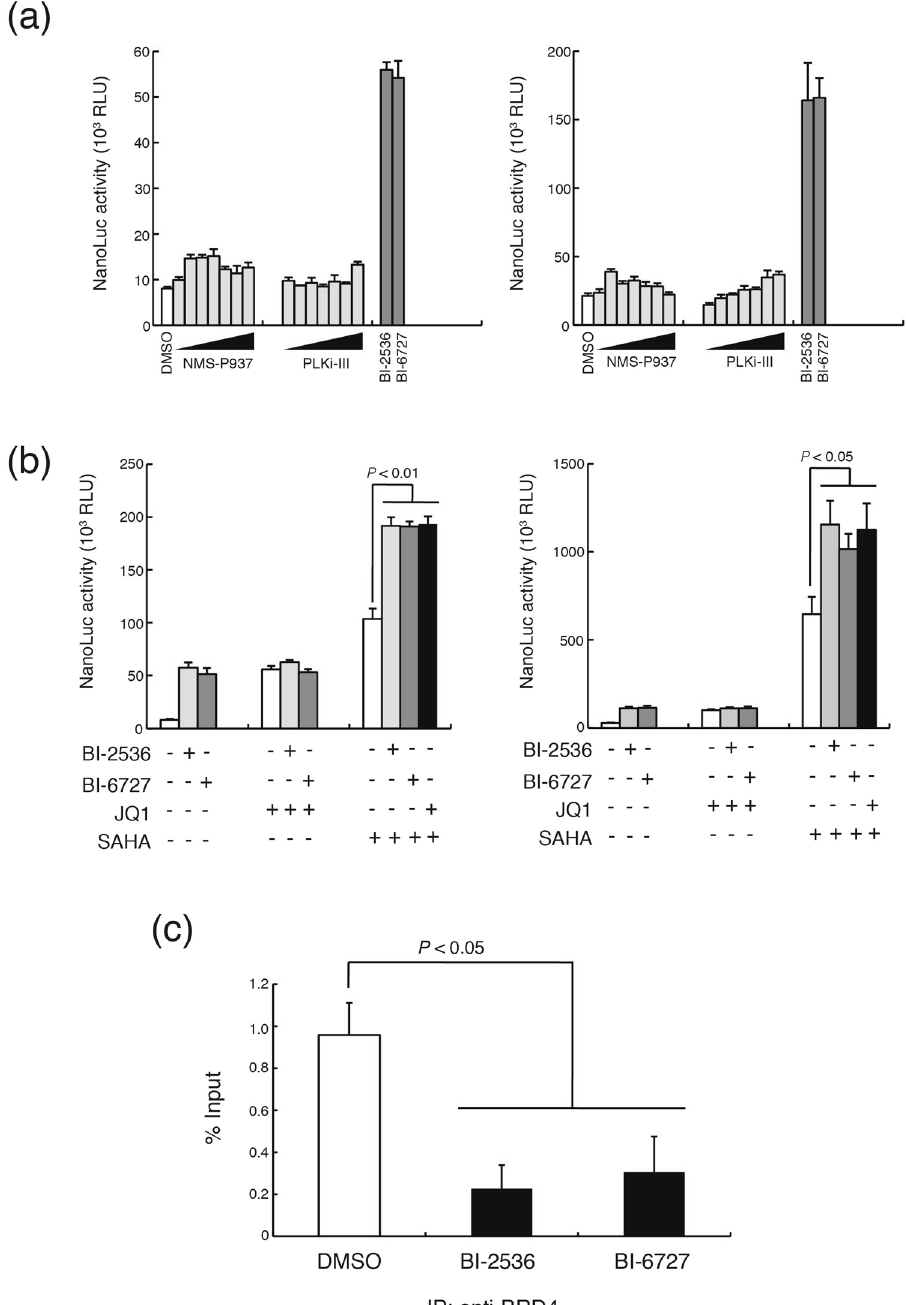
Figure 5. BI-2536 and BI-6727 activate HIV-1 LTR transcription probably through bromodomain inhibition rather than PLK inhibition. ( a ) #95 and #225 THP-1-NanoLuc clones were cultured in 0.1% dimethyl sulfoxide (DMSO) in the absence or presence of NMS-P937 or PLKi-III at 0.01, 0.03, 0.1, 0.3, 1, 3, and 10 μ M for 24 hours. The clones were also cultured with 1 μ M BI-2536 or 1 μ M BI-6727. After the clone cells were harvested and lysed, the NanoLuc activity of cell lysates was determined. Each value is shown as a mean ± standard deviation (SD) of triplicate samples. ( b ) #95 and #225 THP-1-NanoLuc clones were cultured without ( − ) or with ( + ) 1 μ M BI-2536 or 1 μ M BI-6727 in the absence ( − ) or presence ( + ) of 1 μ M JQ1 or 10 μ M SAHA for 24 hours. After the cells were harvested and lysed, NanoLuc activity of the cell lysates was determined. Each value is shown as a mean ± SD of triplicate samples. P -values were determined using Student’s t-test. P -values are significant if less than 0.05. ( c ) #95 THP-1-NanoLuc clone cells were treated with 0.1% DMSO, 1 μ M BI-2536 or 1 μ M BI-6727 for 24 hours and subjected to ChIP assay. The level of BRD4 protein associated with the HIV-1 LTR promoter was determined. ChIP DNA signals were normalized by those of input DNA. Each value is shown as a mean ± SD of triplicate samples. P -values were determined using Student’s t-test. P -values are significant if less than